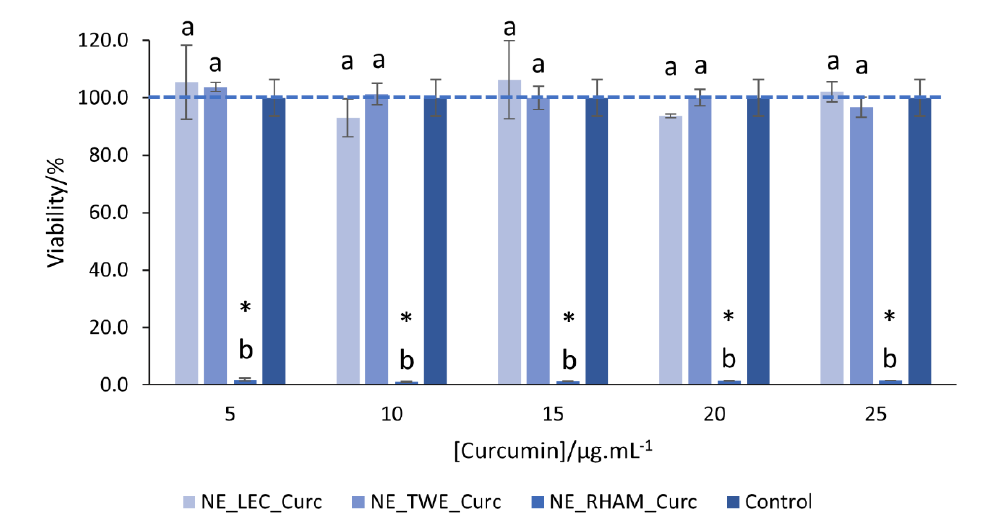
Figure 6. Effect of curcumin-loaded nanoemulsions (NEs) produced with different emulsifiers (lecithin (LEC), rhamnolipids (RHAMs), and Tween ® 80 (TWE)) on viability of Caco-2 cells. Error bars represent the standard deviation of n = 3 replications. a–b Different letters indicate a statistically significant difference between NE/concentration interactions ( p < 0.05). *Asterisks indicate statistically significant differences relative to the control group ( p < 0.05).